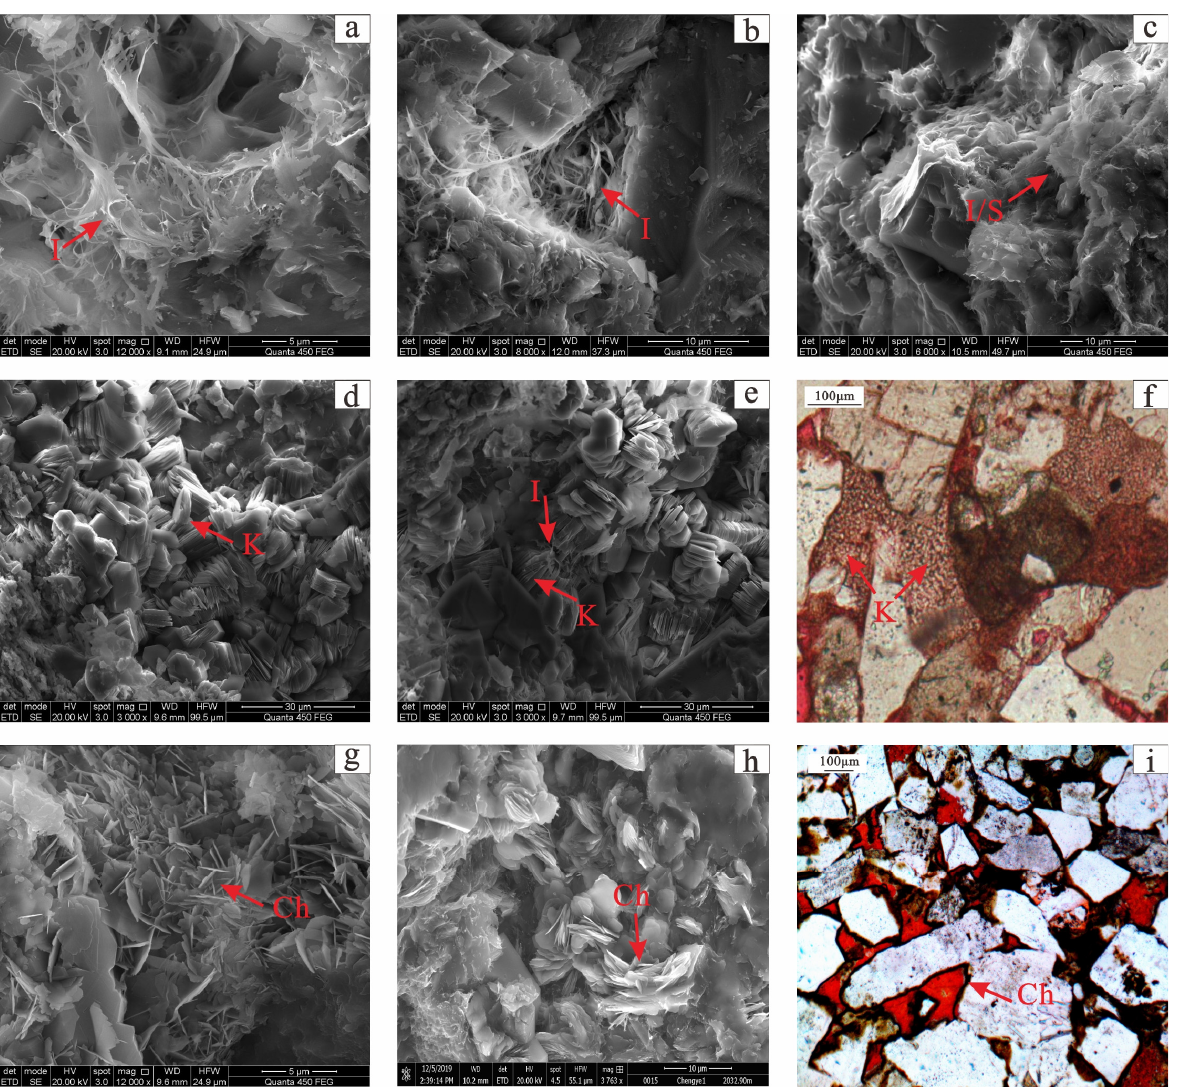
Figure 7. Clay mineral cementation of the Chang-7 Member in the Ordos Basin (I: illite; I/S: mixed- layer illite/smectite; K: kaolinite; Ch: chlorite). ( a ) L304, 2489.6 m, filamentous illite-filled